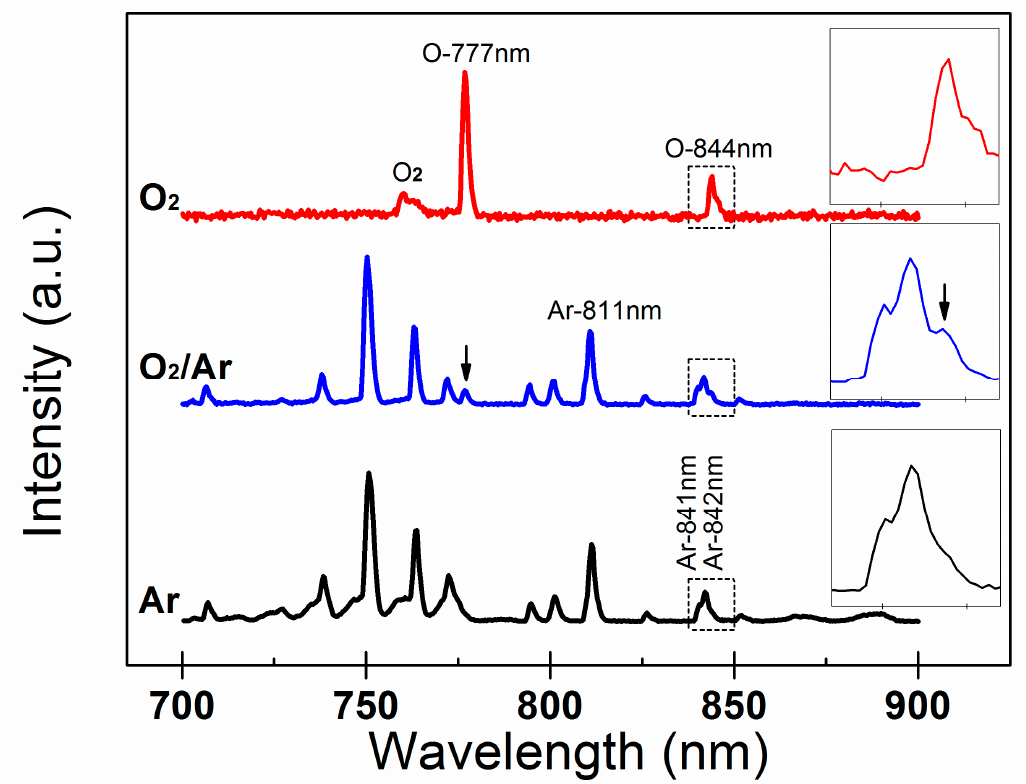
Figure 4. Optical Emission spectra of the Ar (black line), O 2 / Ar (blue line) and O 2 plasma (red line). The insets show the enlarged part from 837 nm to 847 nm, and the two peaks other than O-844 nm are Ar spectral lines, Ar-841 nm and Ar-842 nm,